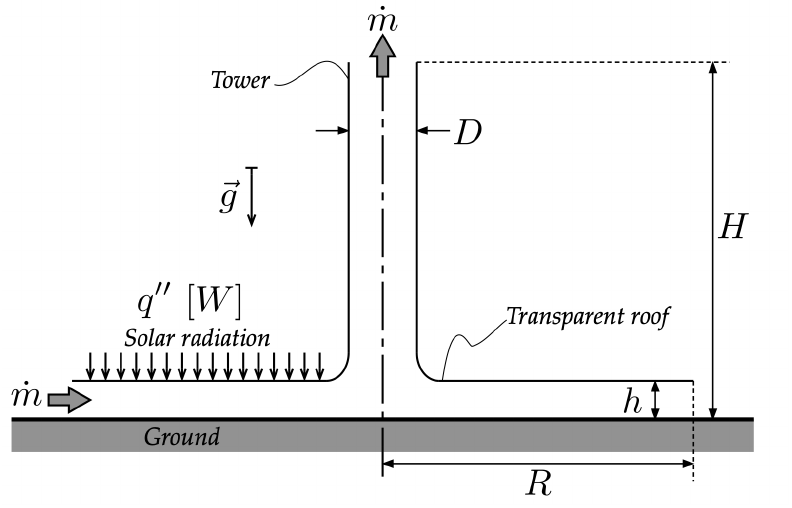
Figure 4. Main features of a solar chimney investigated by Koonsrisuk et al. [24]